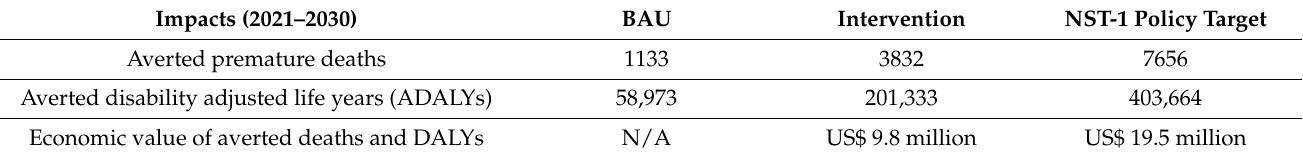
Table 3. Cumulative health impacts of projected LPG adoption for each of the scenarios (2021–2030).